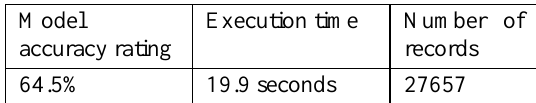
Table 3. Model accuracy of approach